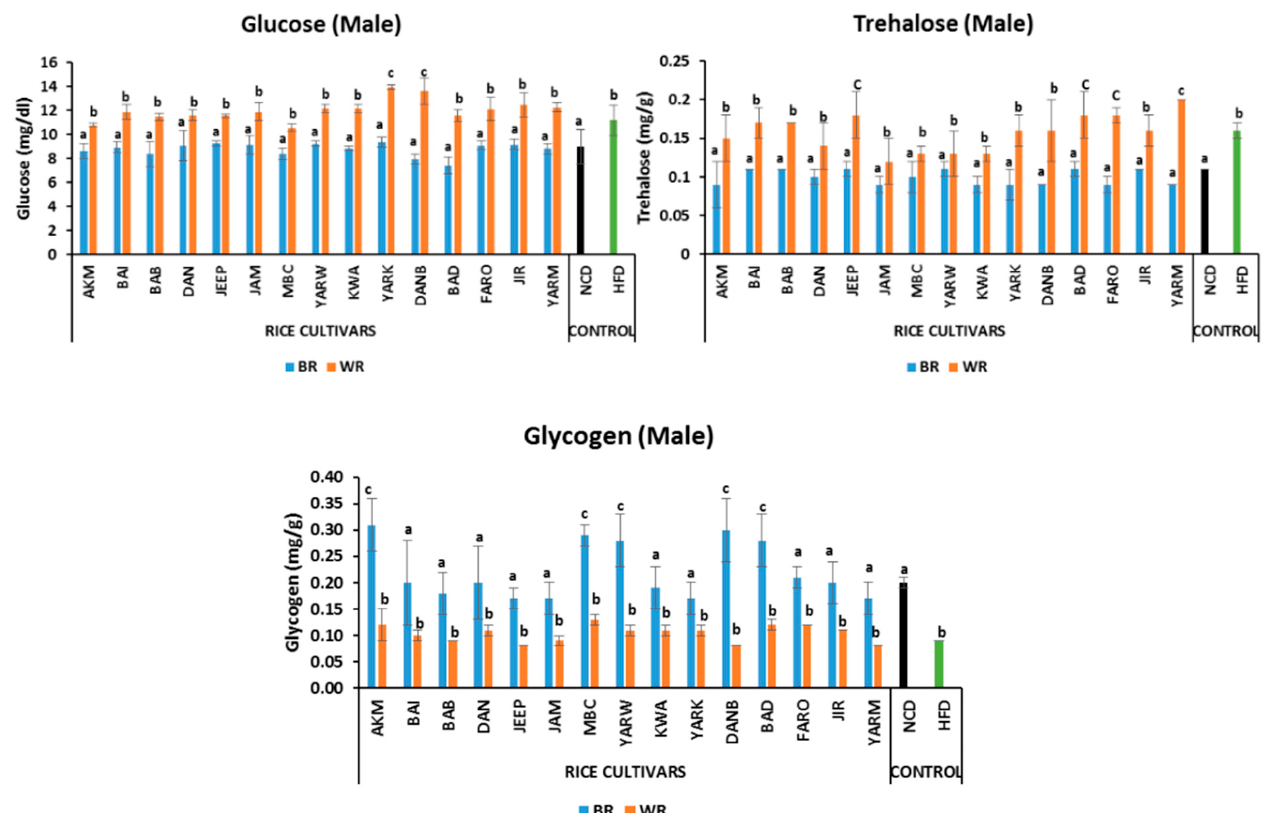
Figure 1. Effects of rice cultivars on the levels of fasting glucose, trehalose and glycogen in male flies after 7 days of intervention diets. Bars represent mean ± SD. Bars denoted by the same letters are not significantly different ( p > 0.05). (n = 30). Black and green bars represent the groups fed normal diet and high fat diet respectively. NCD = normal diet, HFD = high-fat diet Akai maza hajj = AKM, Baingila = BAI, Baburashi = BAB, Jamila = JAM, Maibakincarki = MBC, Yarwasagi = YARW, Kwandala = KWA, Yarkatabore = YARK, Danboto = DANB, Bakindanboto = BAD, Faro 44 = FARO, Jirkita = JIR, Yarkukuma = YARM, Dankaushi = DAN, Jeep =